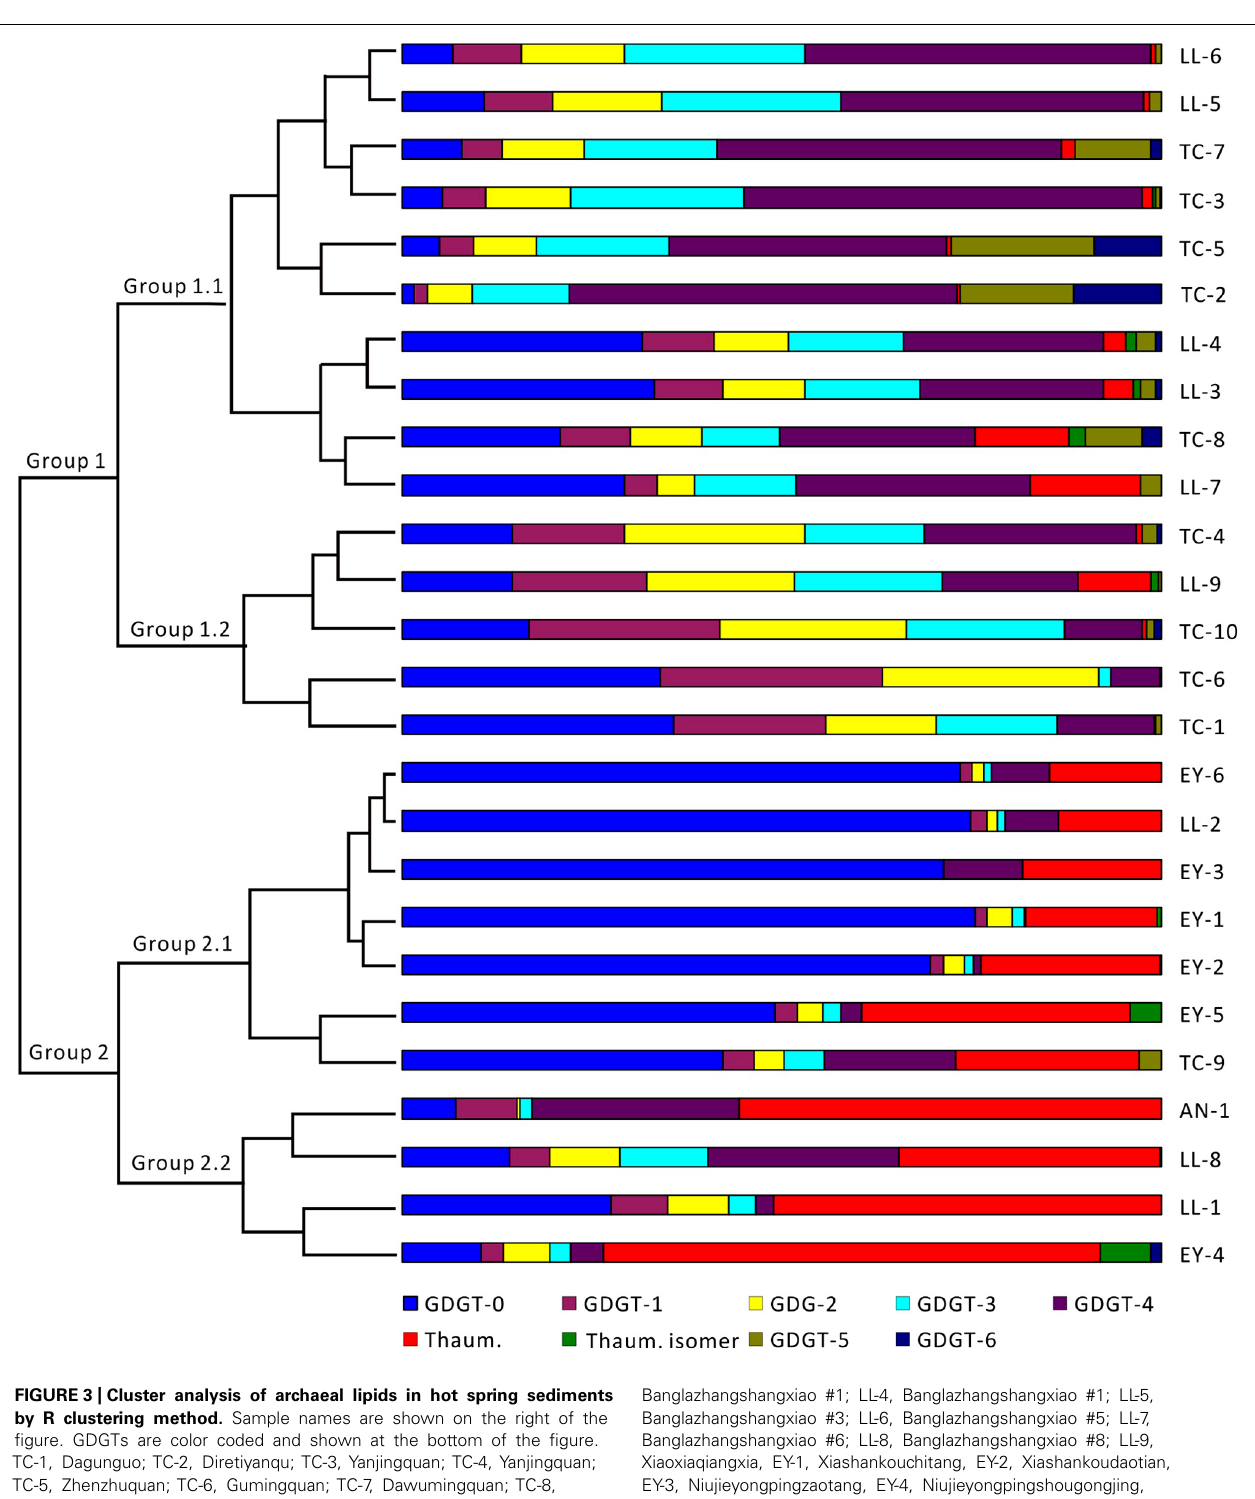
FIGURE 3 | Cluster analysis of archaeal lipids in hot spring sediments by R clustering method. Sample names are shown on the right of the figure. GDGTs are color coded and shown at the bottom of the figure. TC-1, Dagunguo; TC-2, Diretiyanqu; TC-3, Yanjingquan; TC-4, Yanjingquan; TC-5, Zhenzhuquan; TC-6, Gumingquan; TC-7, Dawumingquan; TC-8, Wumingxiaoxishangyou; TC-9, Wumingxiaoxizhongyou; TC-10,